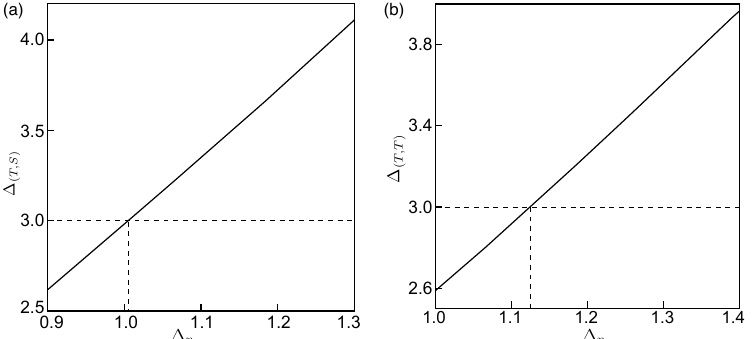
Figure 3: (a-b) Numerical bounds of ∆ ( The allowed region is below the black curve. Here we take Λ =